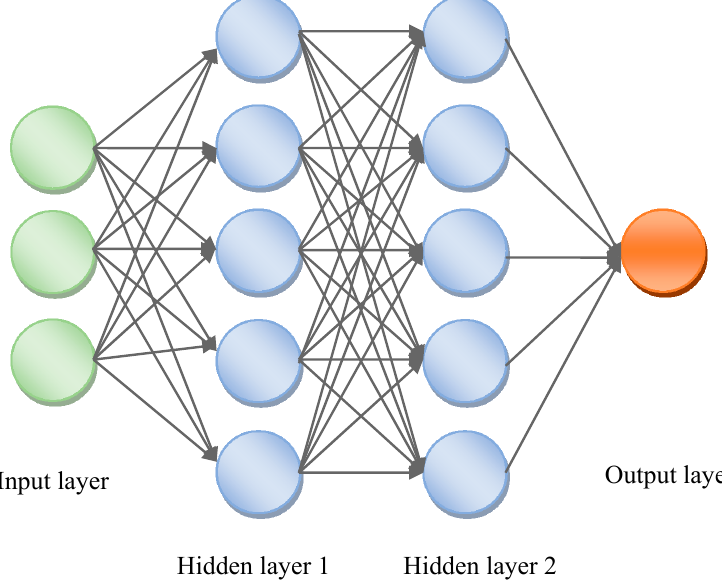
Figure 1. Block diagram of a multilayer perceptron. Adapted from Al-Naymat, G., et al. Classification of VoIP and non-VoIP traffic using machine learning approaches [8].